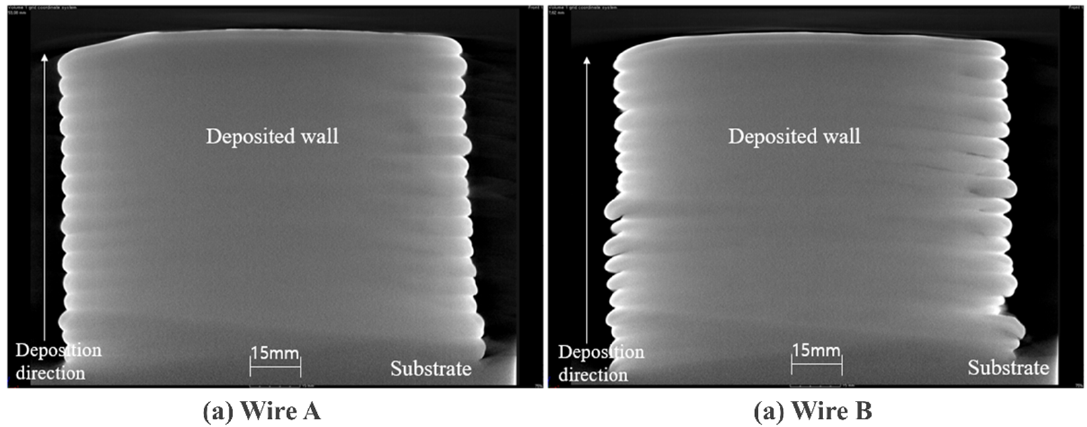
Figure 5. 3D X-ray of additively-manufactured NAB components ( a ) wire A; ( b ) wire B.